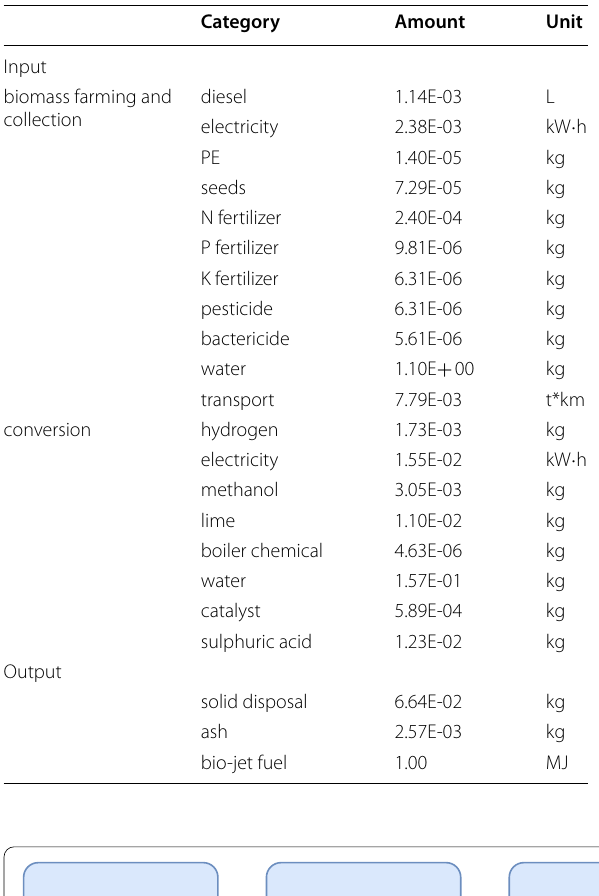
Table 1 LCI for APR technical path [15, 16]